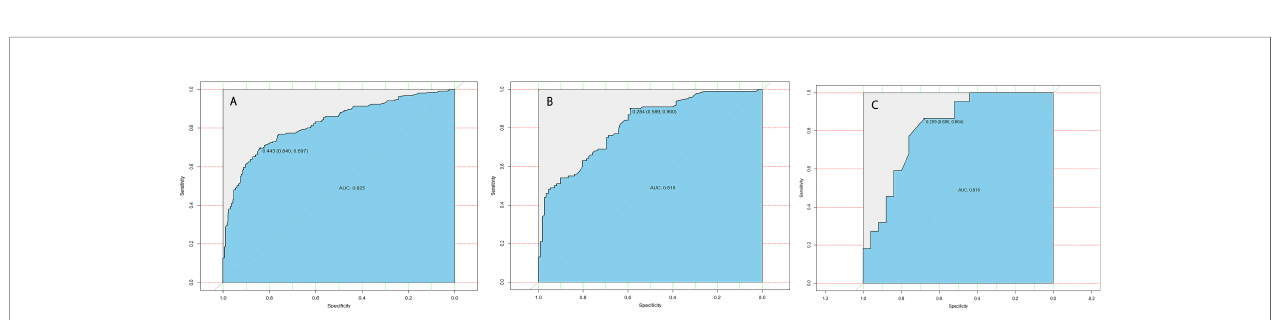
FIGURE 4 | (A) ROC curve analysis to predict LLNM in MTC patients for training set. (B) ROC curve analysis to predict LLNM in MTC patients for the internal testing set. (C) ROC curve analysis to predict LLNM in MTC patients for the external testing